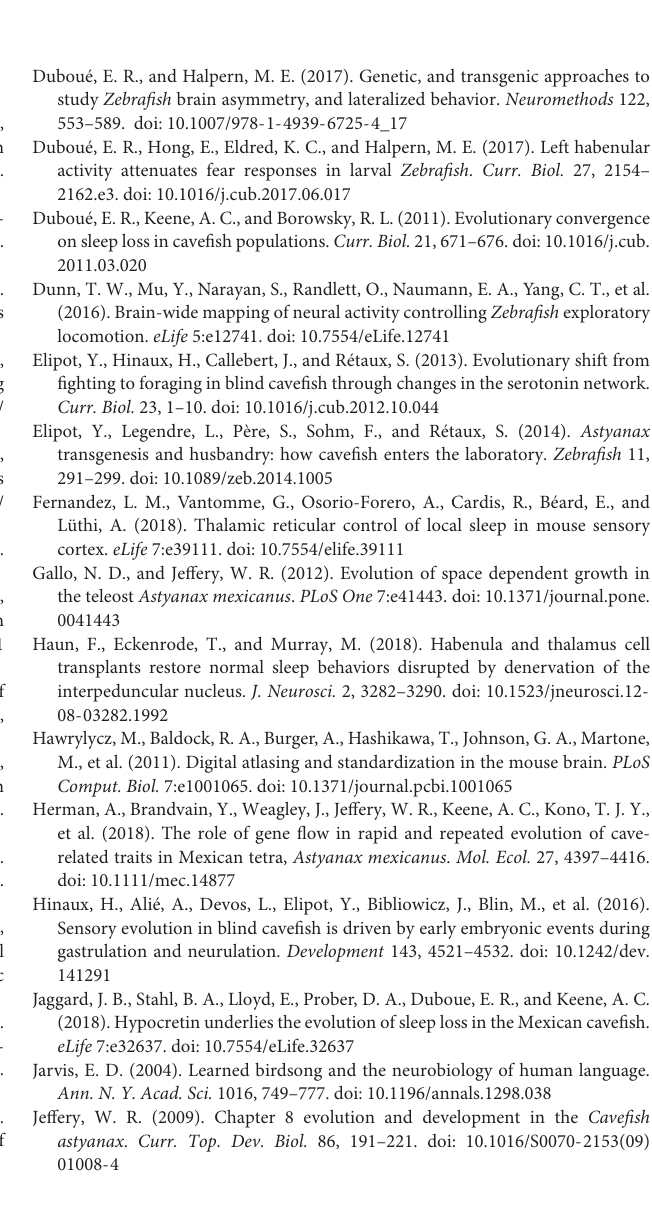
MOVIE S1 | Three-dimensional reconstruction of whole brain from surface fish. MOVIE S2 | Three-dimensional reconstruction of whole brain from Pachón cavefish. MOVIE S3 | Three-dimensional reconstruction of whole brain from Tinaja cavefish. MOVIE S4 | Three-dimensional reconstruction of whole brain from Molino cavefish. MOVIE S5 | Three-dimensional reconstruction of hypothalamus from surface cavefish. MOVIE S6 | Three-dimensional reconstruction of hypothalamus from Pachón cavefish. MOVIE S7 | Three-dimensional reconstruction of hypothalamus from Tinaja cavefish. MOVIE S8 | Three-dimensional reconstruction of hypothalamus from Molino